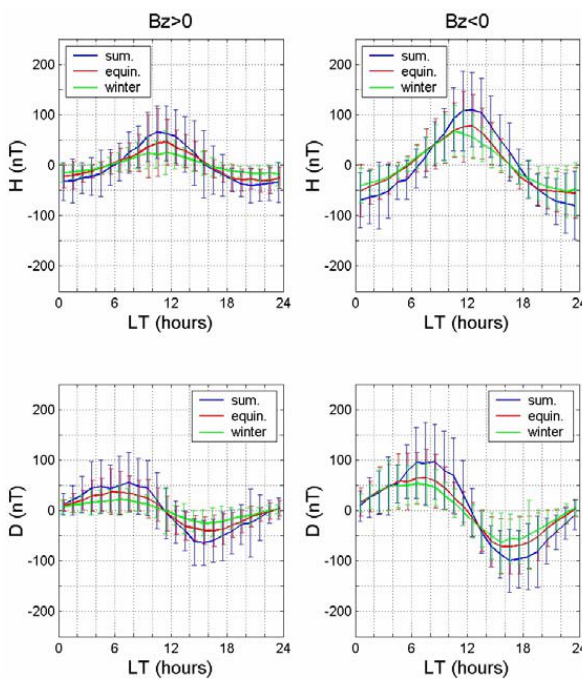
Fig. 5. Daily distribution of the average hourly values and their stan- dard deviation for the H and D components, separately for the three Figure 5. Daily distribution of the average hourly values and their standard deviation for the H Lloyd seasons, for northward (left panels) and southward (right pan- and D components, separately for the three Lloyd seasons, for northward (left panels) and els) IMF conditions. southward (right panels) IMF conditions.